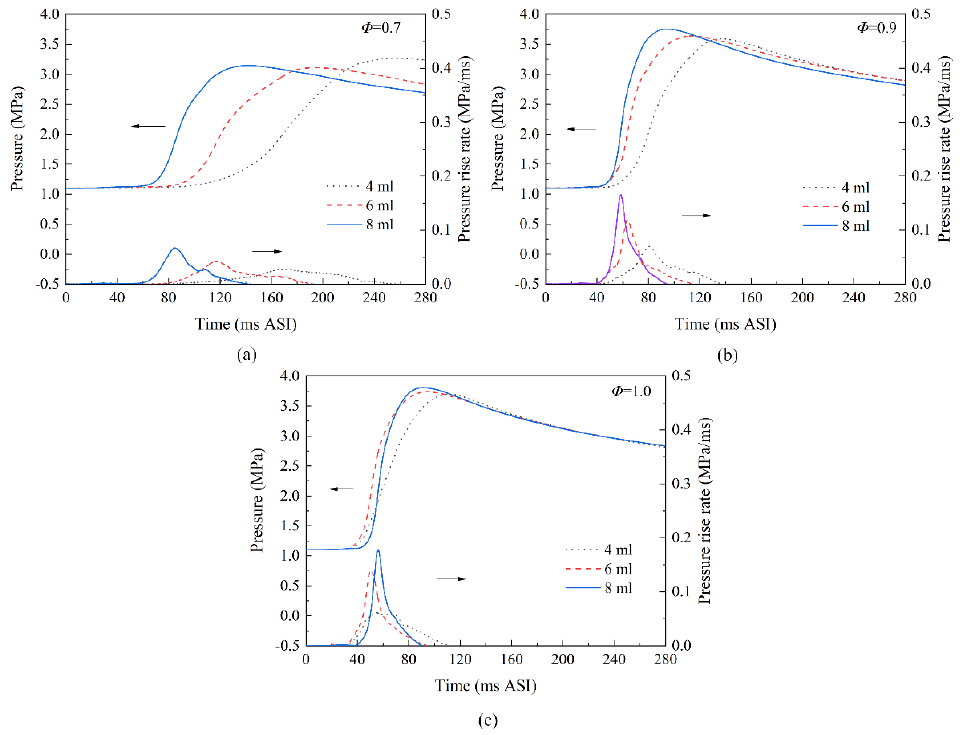
Figure 9. Pressure and pressure rise rate traces in the main chamber for different pre-chamber volumes at different equivalence ratios.